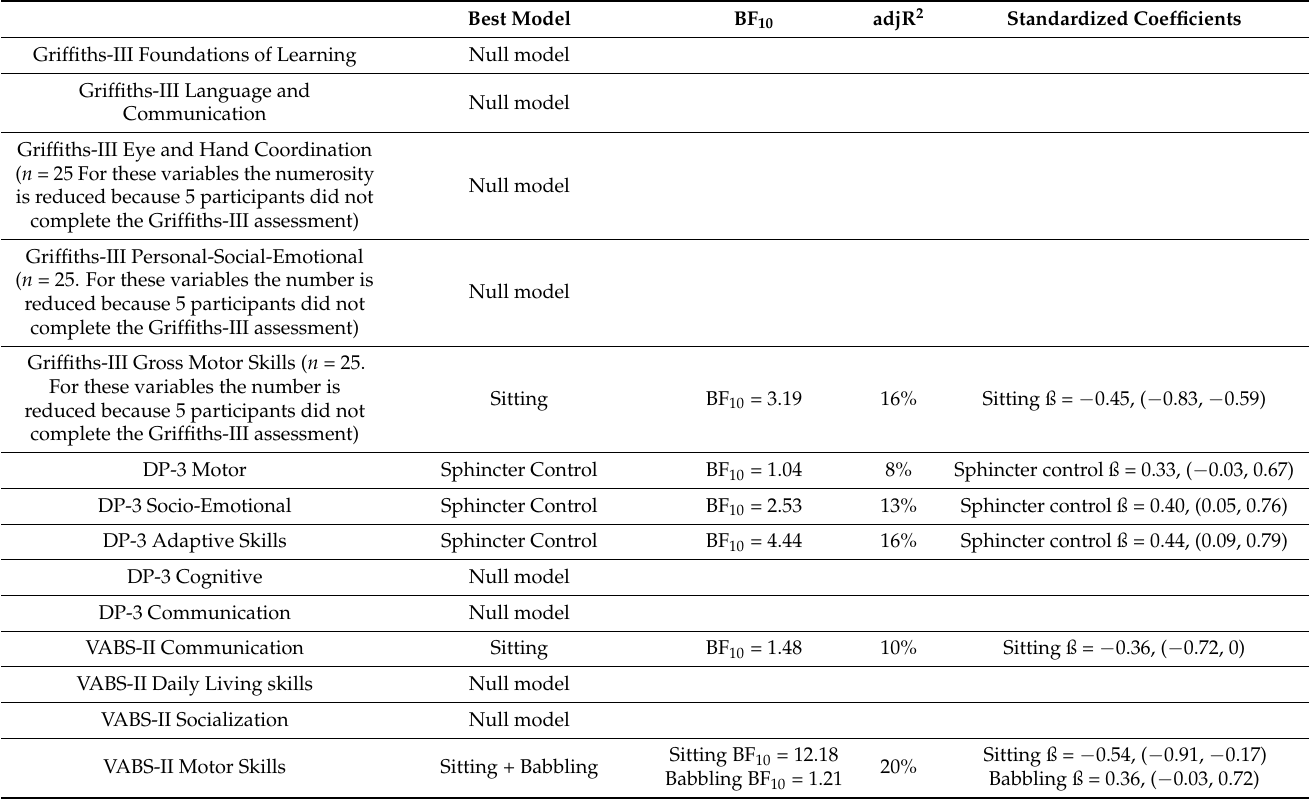
Table 5. Best model selection in the Preschooler group. N =